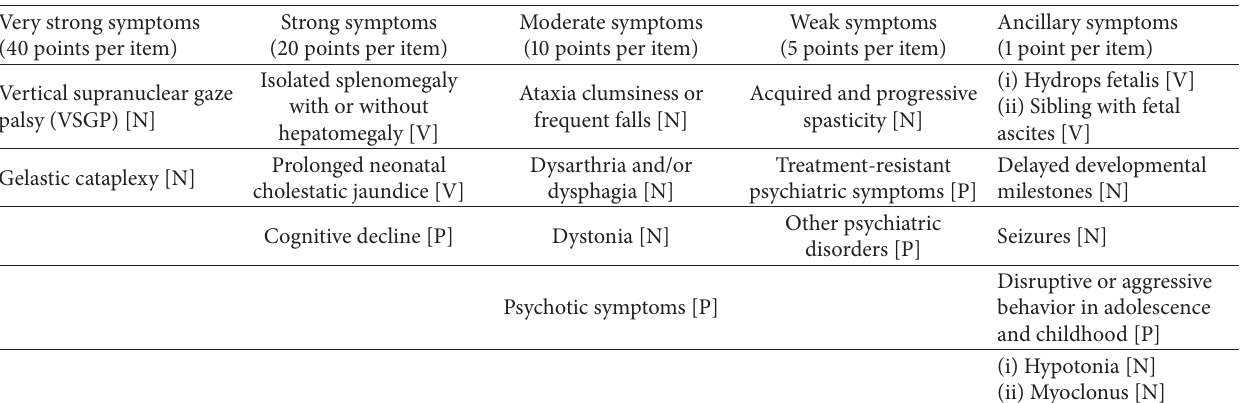
Table 2: Scoring of manifestations, the combination of symptoms, and the patient’s family history, to provide the total NP-C Risk Predication Score (RPS) [4,